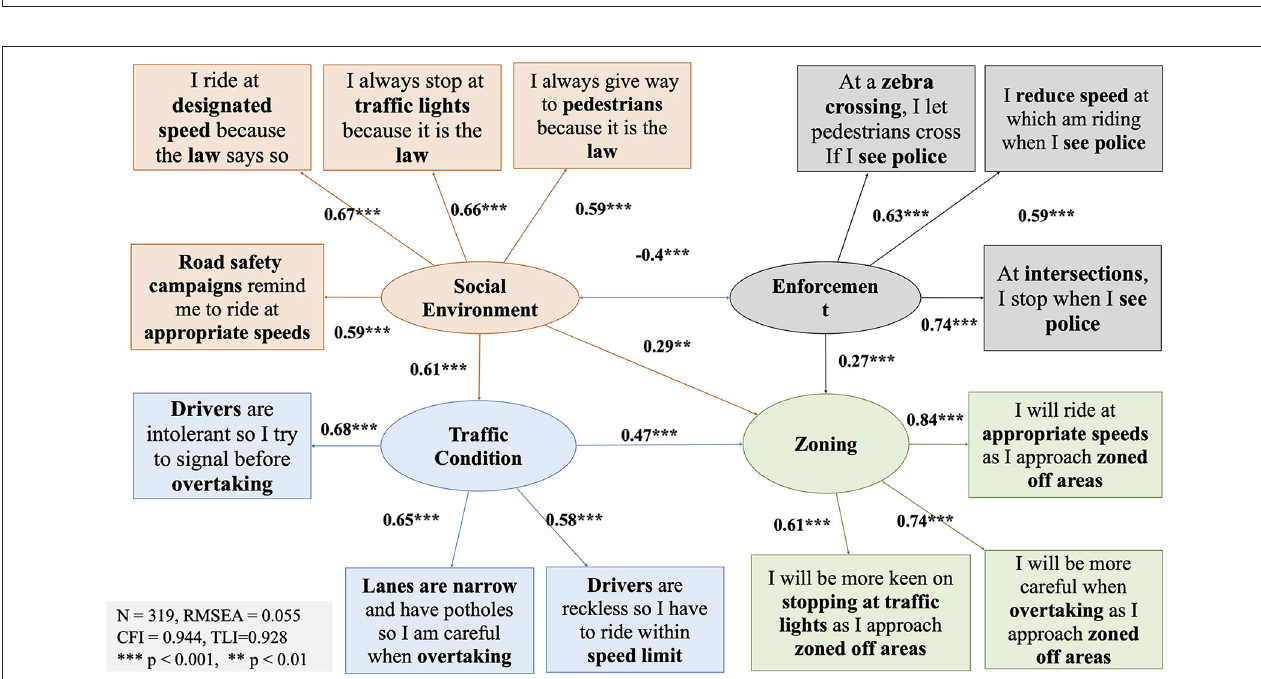
FIGURE 6 | Model 4—The effect of enforcement on zoning.